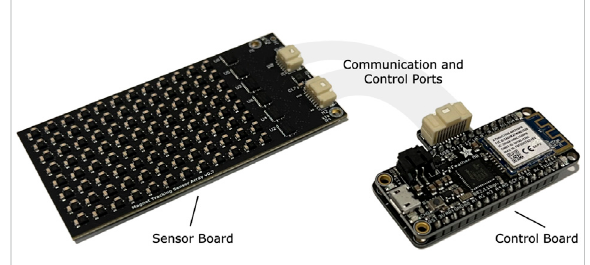
FIGURE 7 Magnetomicrometry Embedded System. We fabricated a custom sensor board (left) and a custom control board (right) for this study. The sensor board holds the magnetomicrometry sensing array, consisting of 96 magnetic fi eld sensors arranged with a spacing of 5.08 mm. Digital multiplexers on the sensor board allow time-domain multiplexing, enabling a single microcontroller on the control board to communicate with and control allmagnetic fi eldsensors onthesensorboard.The control boardmergesthedatafromthesensorboardandstreamsthedata wirelessly to themagnet trackingcomputer. The sensor board and control board weigh 24 g and 12 g,